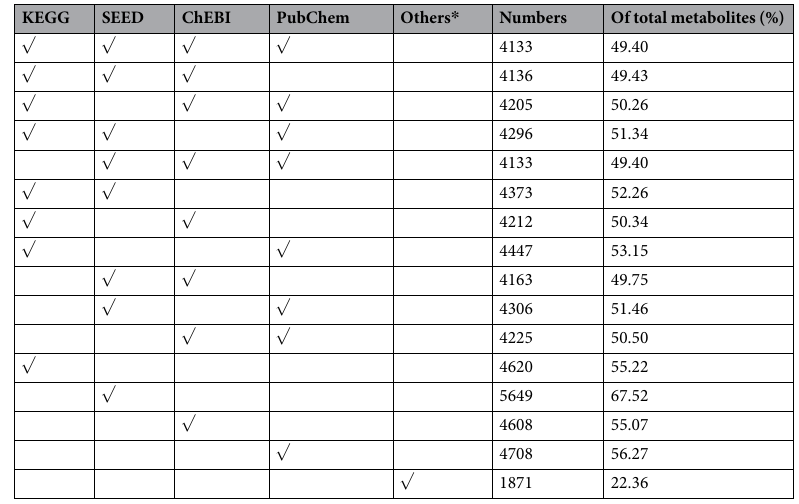
Table 3. Distribution of metabolites from different metabolite databases. * Others indicates that metabolites from 235 models could not be found in any of the four